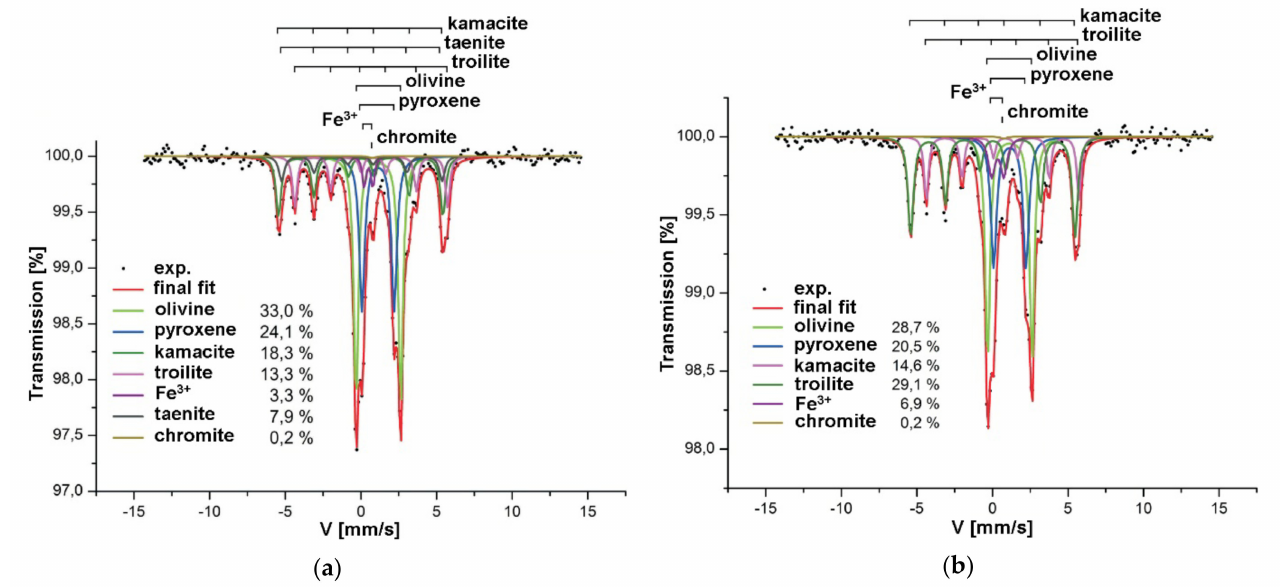
Figure 19. Room temperature Mössbauer spectra of equilibrated ordinary chondrites Carancas H4-5 ( a ) and Juancheng H5 ( b ). Indicated components are the results of the fits. Adapted from Reference